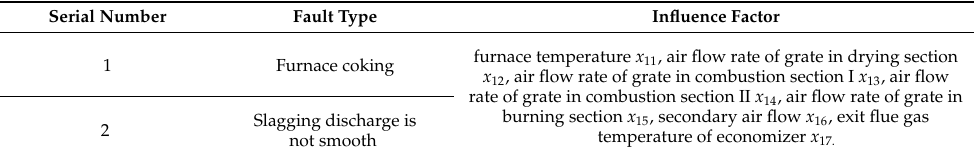
Table 3. Furnace faults and influencing